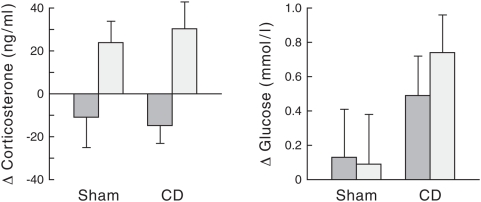
Effect of light at CT14 on hormonal levels in intact vs denervated animals.Changes in the plasma glucose/corticosterone levels after one hour of light exposure at CT14 in sham-operated (n = 8) and CD (n = 10) animals. One-way ANOVA with repeated measures (i.e., Treatment (2 levels: light versus no-light)) and, as between-animal factor, Group (2 levels: sham-operated versus completely denervated CD) were used to assess the changes in plasma glucose/corticosterone levels after one hour of light exposure. Dark bars represent the animals in the non light-exposed condition and white bars represent the same animals after light exposure. Each value is the mean±S.E.M of the delta value (T0–T60 min).